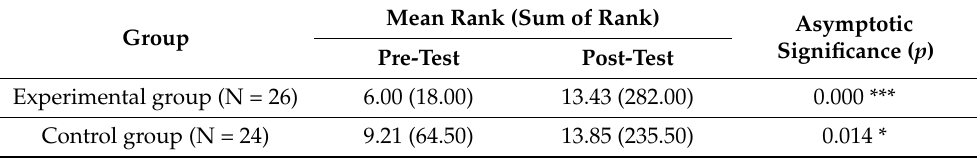
Table 4. The Mann–Whitney U test results between pre-test and post-test.